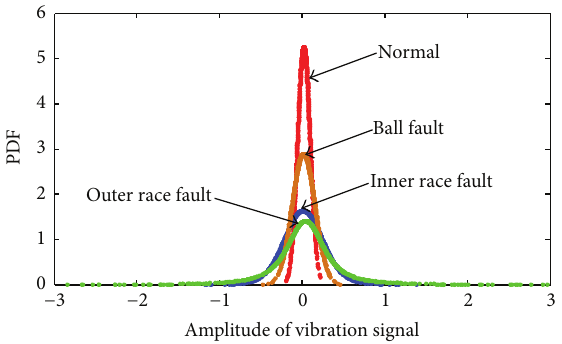
Figure 4: PDF of bearing fault vibration signal.